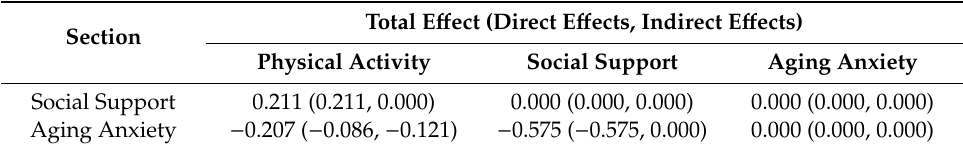
Table 9. Total e ff ect, direct e ff ect, and indirect e ff ect.